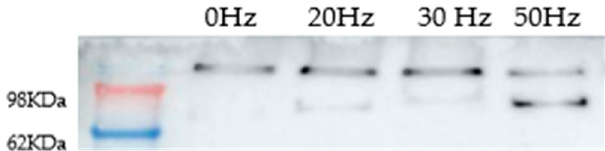
Figure 6. Western blot of HSP90 protein in CT2A non-exposed (0 Hz, Helmholtz coils off) and CT2A exposed during 24 h to an EMF of 100 μ T at different ELF: 20, 30, and 50Hz.